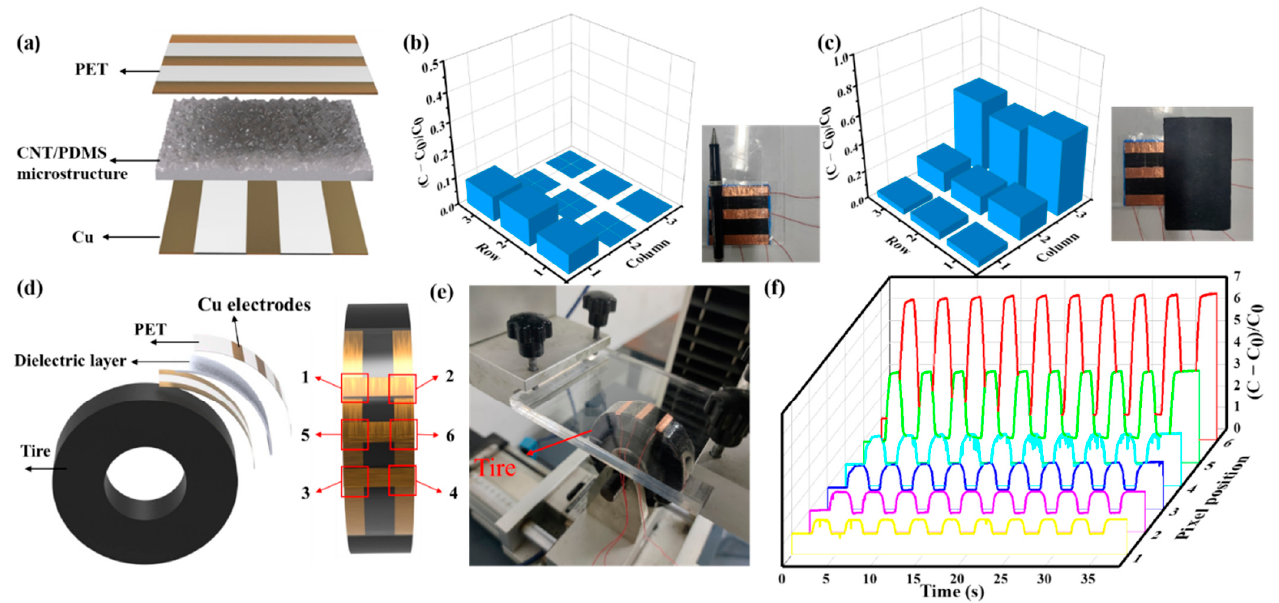
Figure 6. Application of the spinosum pressure sensors. ( a ) Schematic of the 3 × 3 pixelated pressure sensor array. Mapping of pressure distribution on the 3 × 3 sensor array upon ( b ) placing a pen and ( c ) placing a rectangular mass. ( d ) Schematic of the structure of the intelligent tire and the pixel position. ( e ) Photograph of the intelligent tire and test platform. ( f ) The capacitance signal at each pixel position of the intelligent tire under ten decompression cycles.